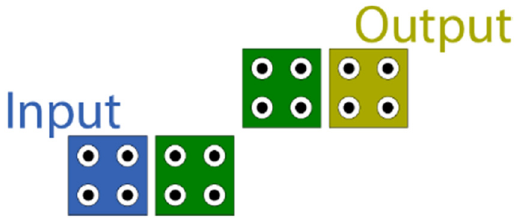
Figure 3: Cell con fi gurations of inverter block.